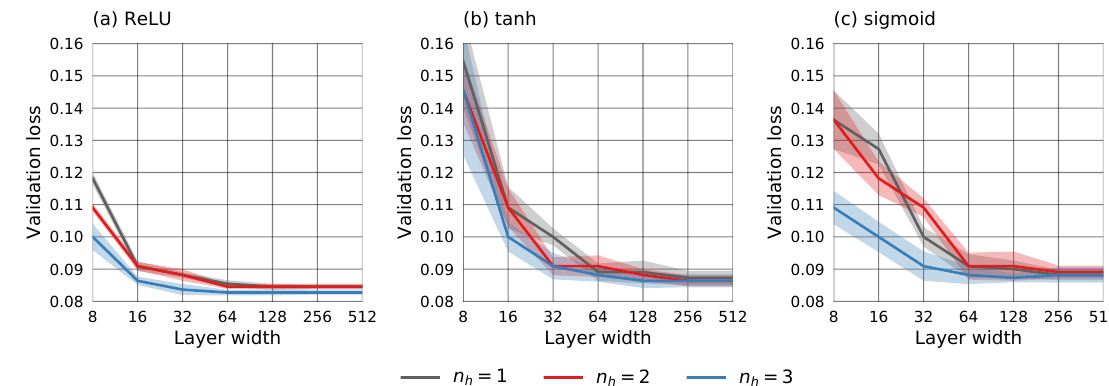
Figure 2. Mean validation set loss (solid lines) and standard deviation (shading) of different hyperparameter configurations with respect to layer width (number of neurons). Different lines display the results for different numbers of hidden layers n h . The three panels show the results for ReLU, tanh and sigmoid activation